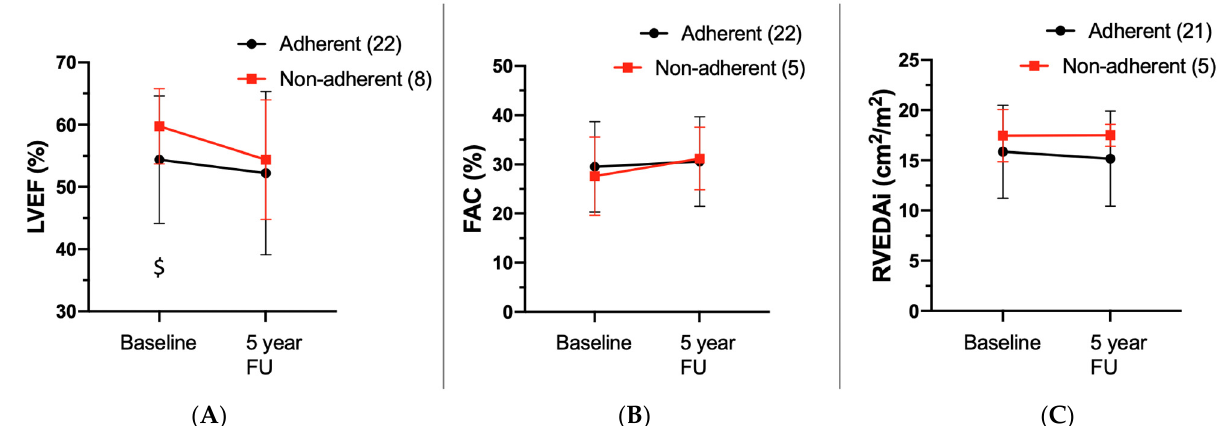
Figure 2 . Echocardiographic findings. ( A ) Comparison of left ventricular ejection fraction (LVEF%) at baseline and follow-up. ( B ) Comparison of fractional area change (FAC%) at baseline and follow- up. ( C ) Comparison of right ventricular end-diastolic area indexed (RVEDAi cm 2 /m 2 ) at baseline and follow-up. Red line indicates cohort, who continued physical activity (non-adherent); black line indicates cohort, who stopped physical activity (adherent $ indicates p < 0.05 for independent Student’s t -test between the two cohorts.